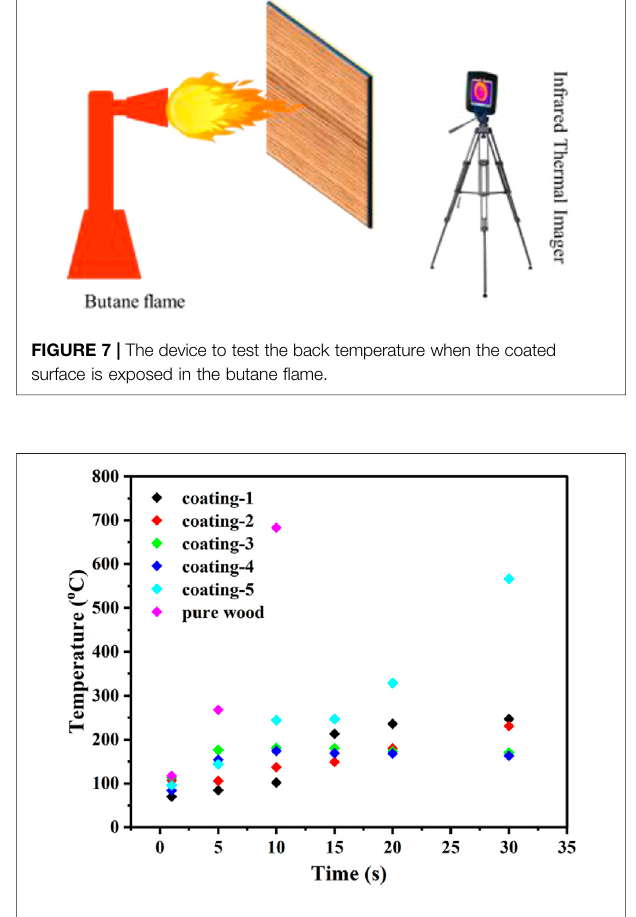
FIGURE 8 | The scatter plot of back temperature change of wood when the surface was exposed in the butane fl ame.